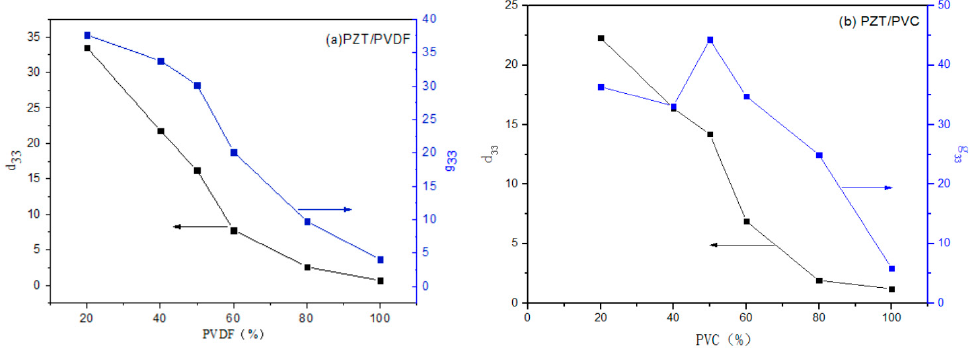
Figure 7. ( a ) Effect of PVDF volume fraction of the d 33 of PZT/PVDF; ( b ) Effect of PVDF volume fraction of the g 33 of PZT/PVDF.